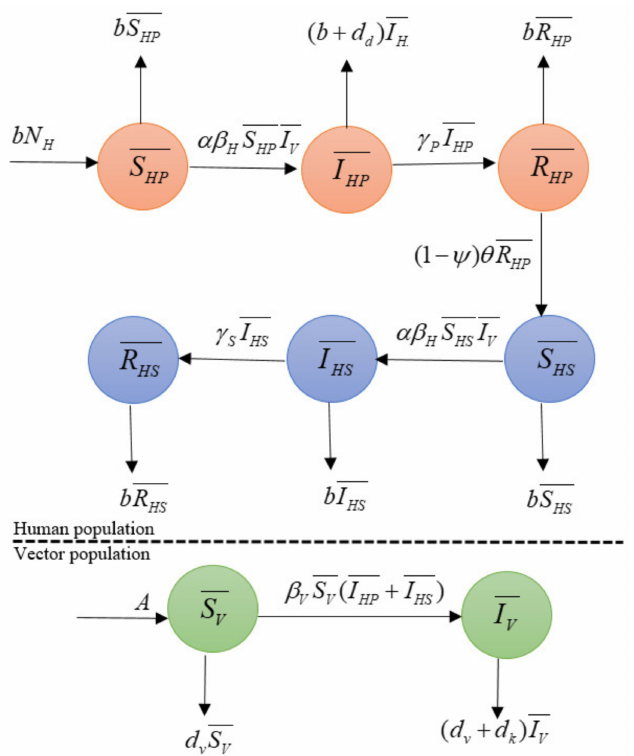
Figure 2. Diagram of the transmission model of dengue disease with the vaccination model of human and vector